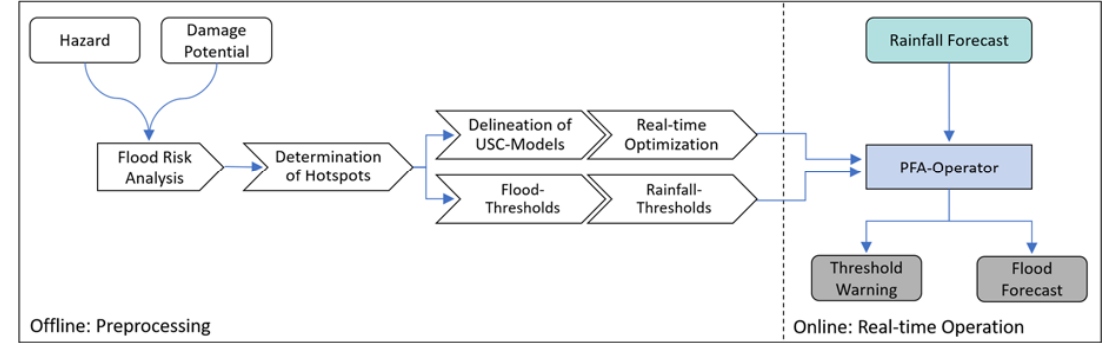
Figure 1. Offline and online components for the operational implementation of the framework. Figure 1. O ffl ine and online components for the operational implementation of the